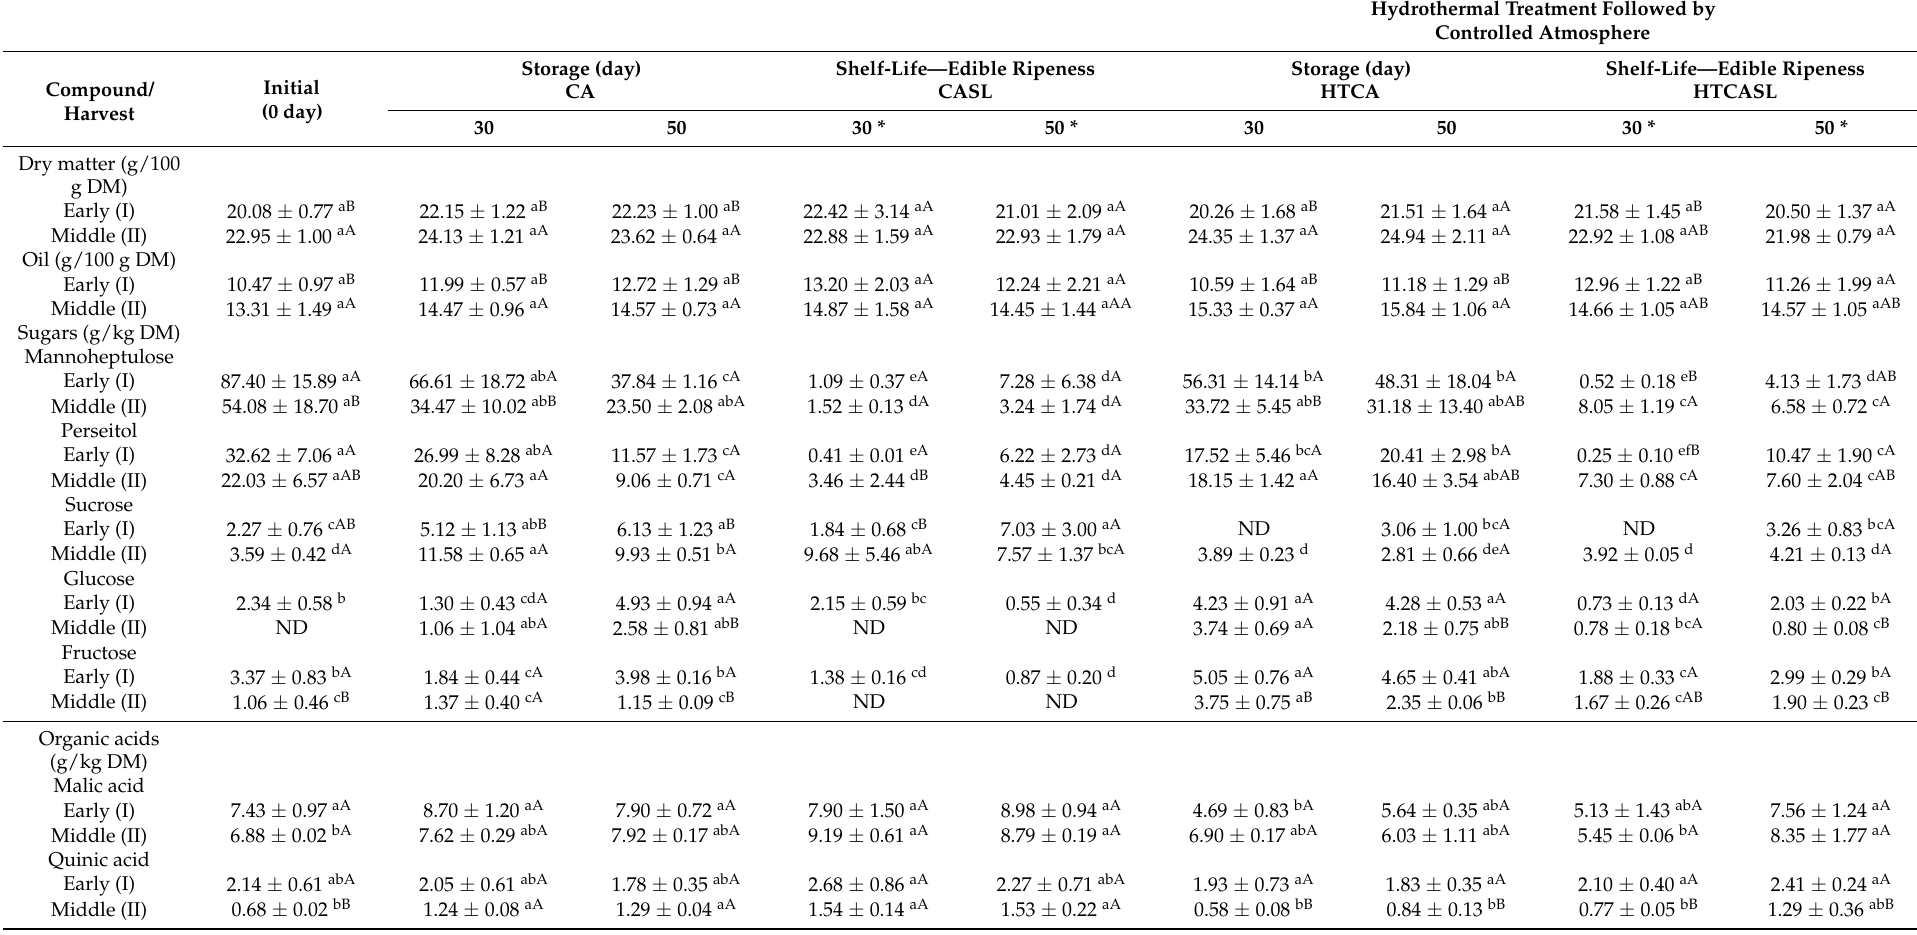
Table 1. Content of dry matter, oil, sugars, and organic acids in Hass avocado from two harvests (early and middle) at harvest (initial), after controlled atmosphere storage, and with previous hydrothermal treatment followed by controlled atmosphere storage, and at their corresponding edible